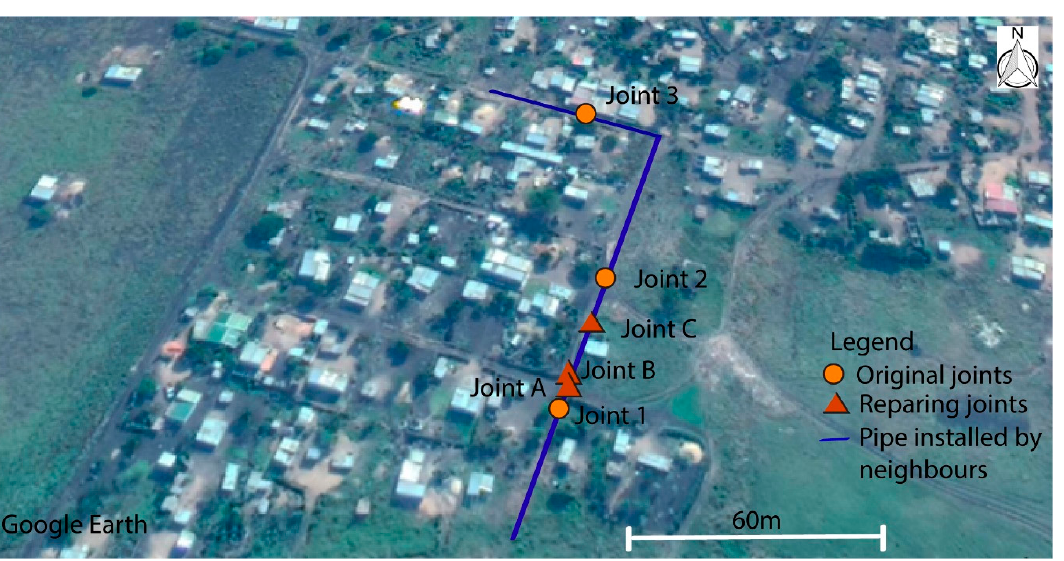
Figure 7. Location of joints in the pipe installed by the neighbors in Block Q11 (Map: Chitata, 2019). Not only the joints leak but also sections of the pipe in between the joints regularly burst.